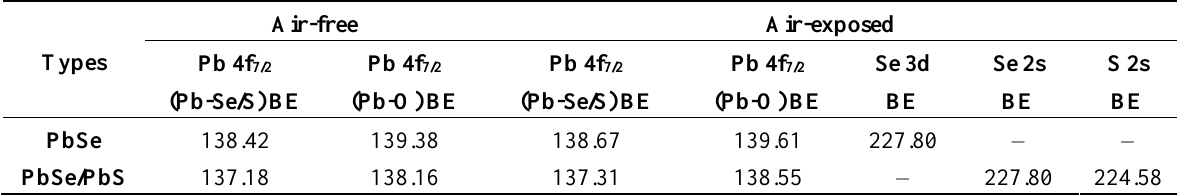
Table 1. Binding energies (BEs) corresponding to the XPS peaks of the PbSe and PbSe/PbS QDs as in Figure